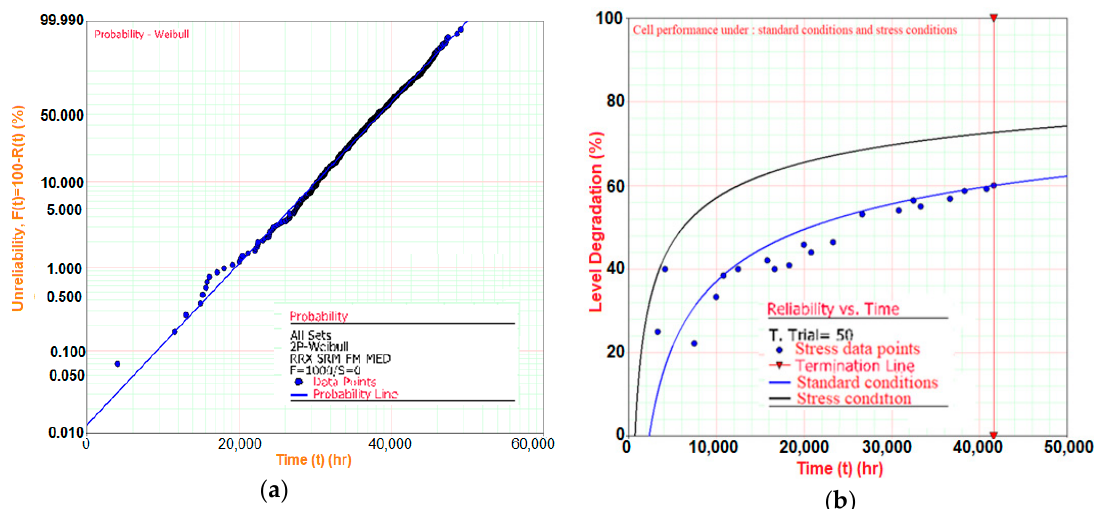
Figure 16. ( a ) Weibull distribution for the studied solar cell lifetime; ( b ) solar cell performance and degradation degree of the analyzed solar cell under standard and stress conditions.